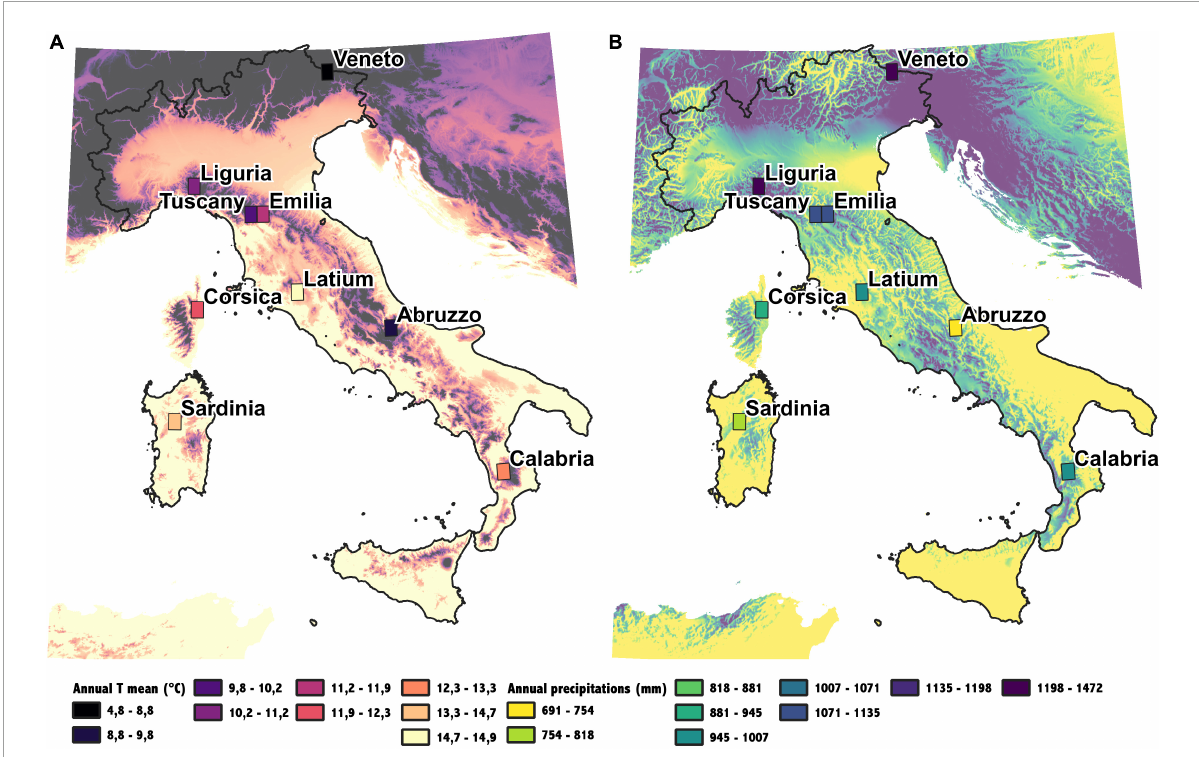
FIGURE2 Climatic conditions in the studied area. Annual mean temperature (A) and Annual precipitation (B) . The rectangles indicate ERA5 pixels used for each site, the color inside rectangles is the mean value of temperature and